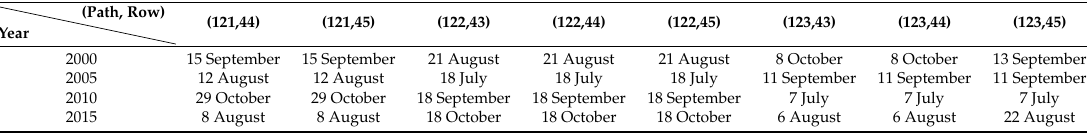
Table 1. Data collection of Landsat 4-5/8 from 2000 to 2015.